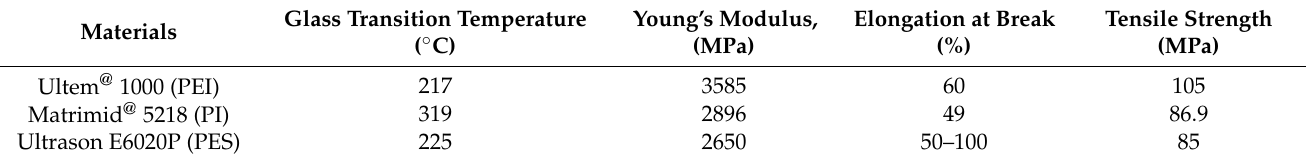
Table 1. Physical and mechanical characteristics of polymers [8].